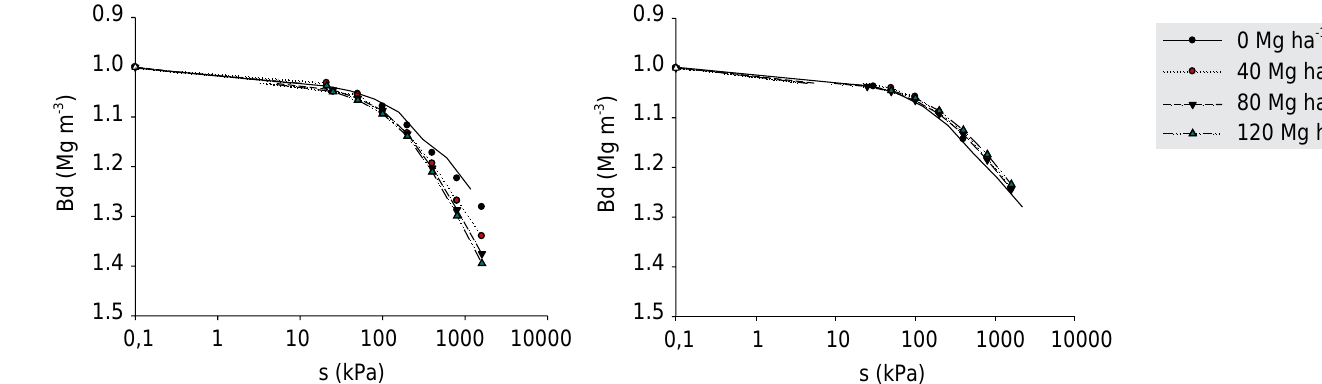
Figure 7. Normalized compression curves of bulk density (Bd) versus applied loads of a Typic Hapludult under different rates of rice husk ash in the 0.00-0.10 (a) and 0.10-0.20 m (b) layers.